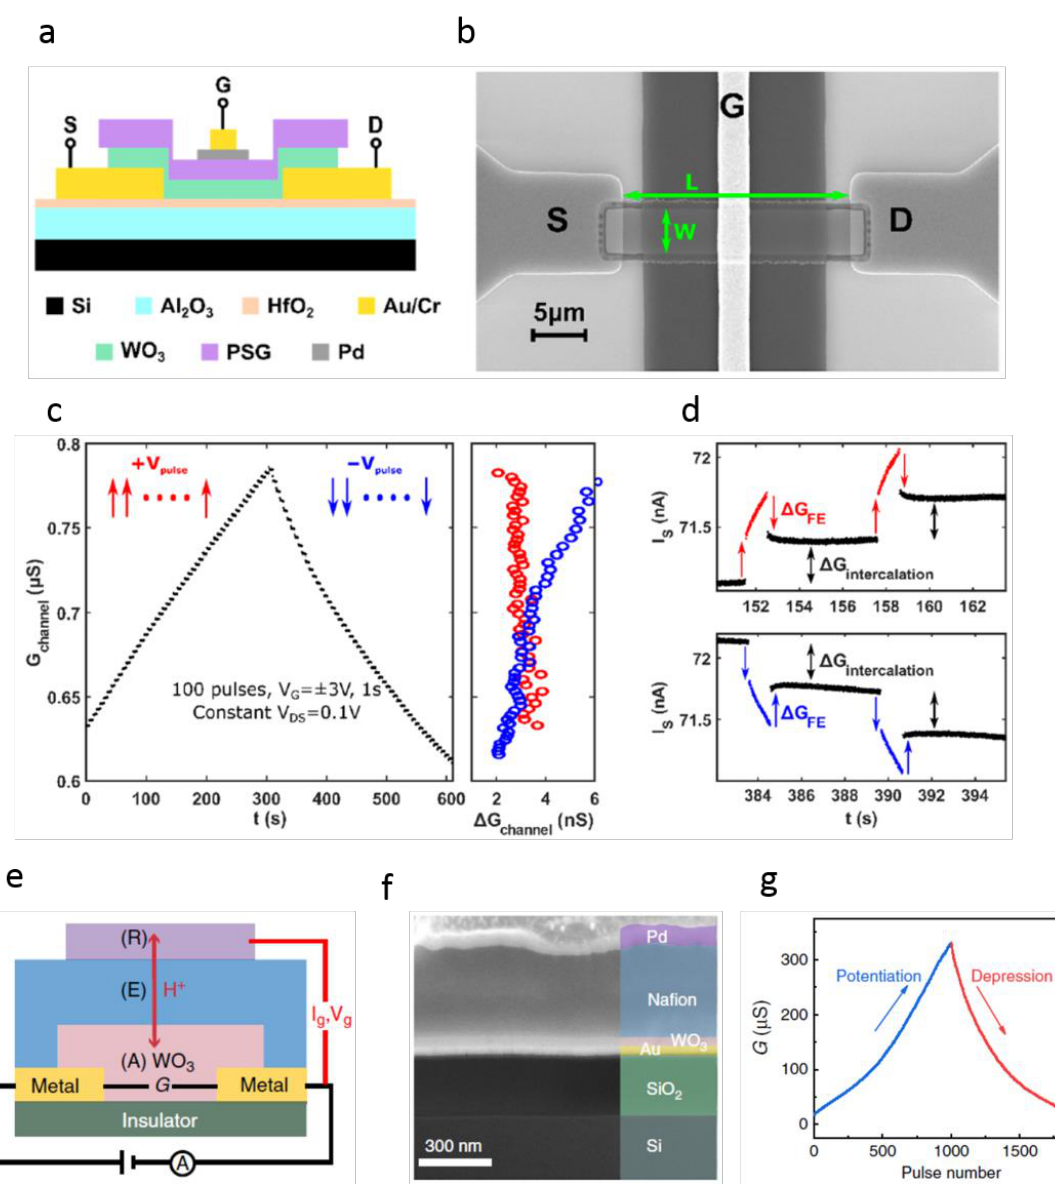
Figure 11. ( a ) Schematic illustration of the protonic programmable resistor for CMOS – compatible electrochemical three – terminal synaptic device. ( b ) The top – view scanning electron microscope image of an electrochemical three – terminal synaptic device with phosphosilicate glass as an electrolyte layer. ( c ) Potentiation – depression curve of a CMOS – compatible electrochemical three – terminal synaptic device consisting of phosphosilicate glass as an electrolyte layer obtained by injecting 100 consecutive pulses with ± 3 V amplitude and 1s duration. This curve shows high linearity and low cycle – to – cycle variability. ( d ) The current response of the channel for multiple discrete currents with nonvolatile behavior in a CMOS – compatible electrochemical three – terminal synaptic device with phosphosilicate glass. Reprinted/adapted with permission from Reference [56]. 2021, American Chemical Society. ( e , f ) Cross – sectional schematic illustration ( e ) and scanning electron microscopy image ( f ) of an inorganic electrochemical three – terminal synaptic device based on proton intercalation in a WO x channel. ( g ) Potentiation – depression curves of an inorganic electrochemical three – terminal synaptic device with the proton – conductive solid – polymer electrolyte (Nafion – 117) as electrolyte, via operation spikes of ± 200 nA amplitude with 5 ms duration. The curves reveal high linearity, a large dynamic range, and high precision. Reprinted/adapted with permission from Reference [57]. 2020, Springer Nature.